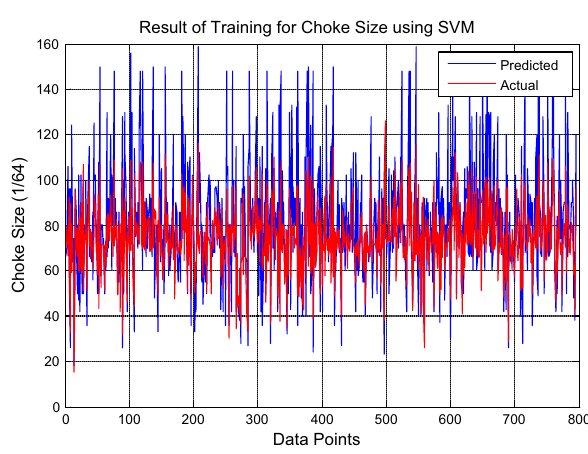
Fig. 21 Correlation between the actual and the predicted choke size for testing data (Poly function) ( R =